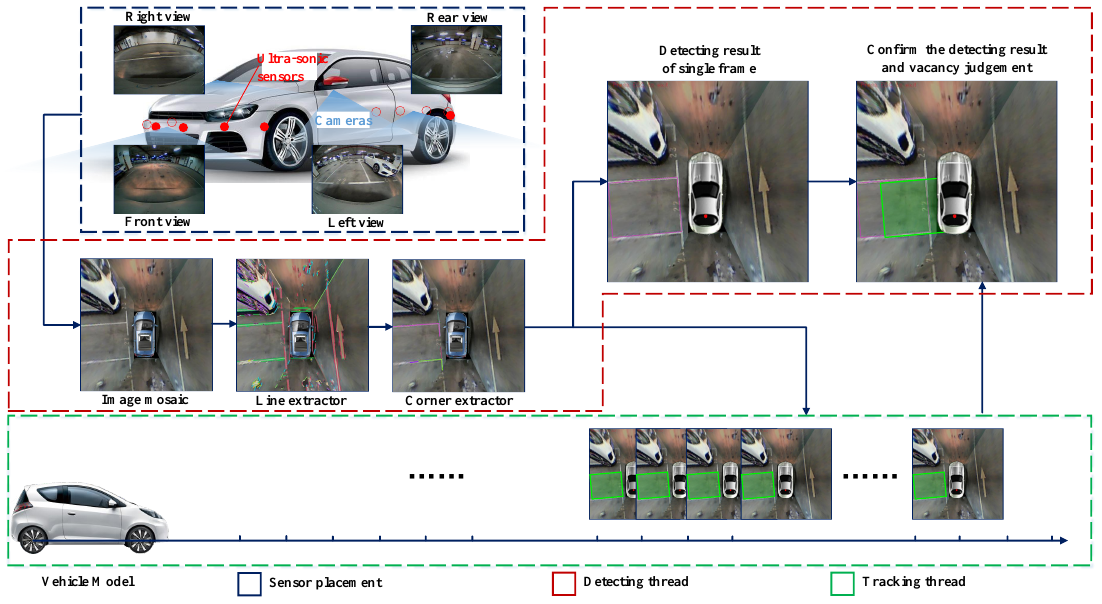
Figure 2. System diagram of parking area detection. Sensor placement is demonstrated in the dash box where the red dots stand for ultra-sonic and blue areas stand for the undistorted FOV of the surrounding